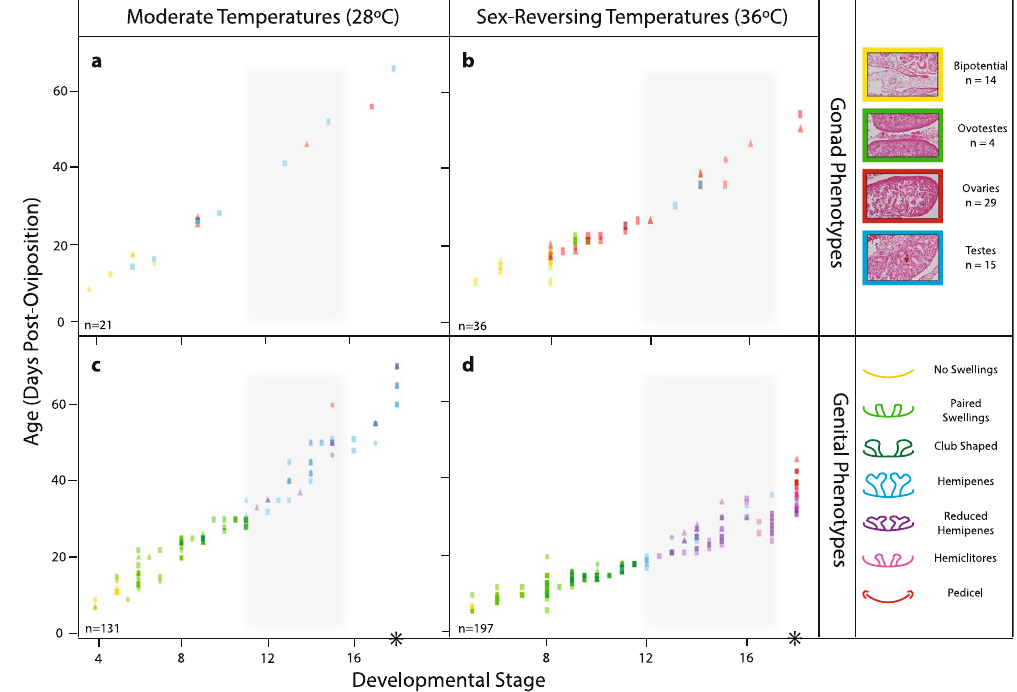
Figure 3. Timing of gonad ( a , b ) and genital ( c , d ) development for Pogona vitticeps at normal (28 °C; a , c ) and sex-reversing (36 °C; b , d ) incubation temperatures. Sexual phenotype is indicated by colour as per the legend, and sexual genotype is indicated by shape (squares = ZZ specimens, triangles = ZW specimens, circles = unknown). The grey shading defines the period of temporary pseudohermaphroditism during female development, persisting for approximately 9 stages. The black asterisks denote approximate time of hatching (stage 18, ~73 dpo at 28 °C and ~47 dpo at 36 °C; Holleley et al . 19 ). Genital development data was re-analysed from Whiteley et al . 27